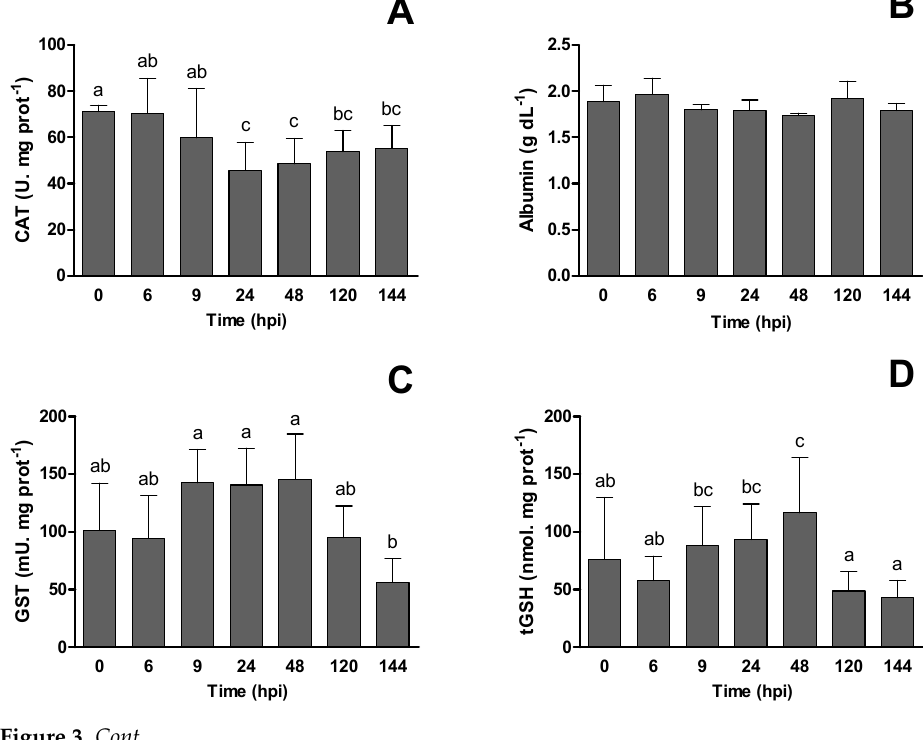
Figure 3. Antioxidant activity in the liver and albumin plasma concentration in European seabass ( Dicentrarchus labrax ) infected with RGNNV at different sampling times post-infection (hpi): ( A ) catalase activity (CAT), ( B ) albumin, ( C ) glutathione-s-transferase activity (GST), ( D ) total glutathione (tGSH), ( E ) superoxide dismutase (SOD) and ( F ) lipid peroxidation (LPO). Values are presented as mean ± SD ( n = 6). One-way ANOVA was used to compare between different sampling times. Different letters show statistically significant differences between sampling times ( p < 0.05). 3.4. Viral Quantification A standard curve was prepared by using serial dilutions of viral RNA to establish a linear regression between mean Ct values and dilutions, with a starting concentration of NNV at TCID 50 = 10 7 mL − 1 (Supplementary Figure S1). The quantification of the virus in unknown samples was determined from the following equation: y = − 3.5422x + 36.407, with R 2 = 0.9945. The quantification of NNV in brain tissue was determined at 48 and 144 hpi. Virus was not detected at 0 hpi prior to infection. There was a significant increase ( p < 0.05) in the amount of virus detected at 48 (8.24 × 10 5 TCID 50 mL − 1 ) and 144 hpi (1.18 × 10 7 TCID 50 mL − 1 ). No virus was detected in the control fish. 3.5. Immune Genes Expression The expression of immune genes in the head kidney of European seabass was evaluated after infecting the fish with NNV. At 48 hpi, a significant increase in mxA gene expression was observed, and then it decreased until the end of the sampling period at 144 hpi (Figure 4A). irf3 expression peaked at 6 hpi and then decreased from that point